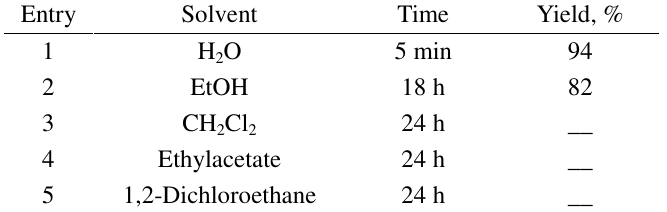
Table 1. Effect of solvents in the synthesis of 4- H -benzo[b]pyran4- H -benzo[b]pyrans ( 4c ) using 2 mol% of Zn(Ph) Cl complex at room 2 2